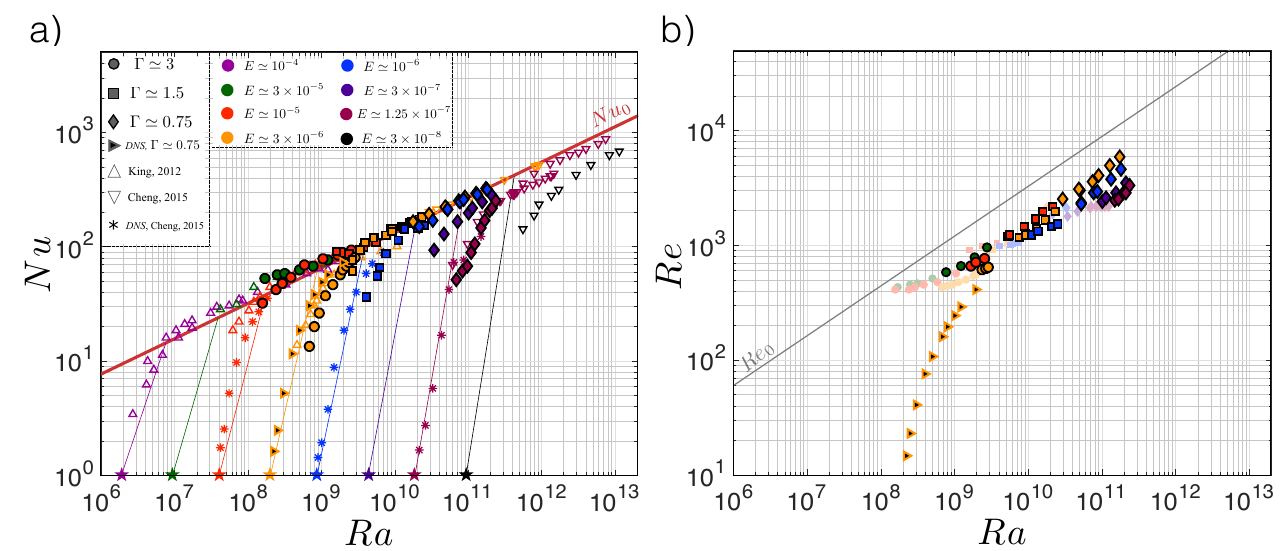
Figure 5. ( a ) Nu vs. Ra RRBC results, where circles denote laboratory data with Γ 3, squares denote (cid:39) laboratory data with Γ 1.5, and diamonds denote laboratory data with Γ 0.75. Color represents (cid:39) (cid:39) the non-dimensional rotation period, E . The right pointing orange triangles with black centers represent the fixed Γ 0.74, E 3 10 − 6 DNS of this study. Open, colored triangles represent the (cid:39) (cid:39) × data from [64] and open, colored upside-down triangles represent the data from [65]. The asterisks denote the DNS from [65]. The onset of steady convection, given by (11), is shown as solid, colored stars. The colored, thin solid lines past onset characterize the regime given by (12) and (13). The thick fuchsia line shows the RBC empirical findings from Figure 4a. ( b ) Re vs. Ra RRBC results, where the colors and symbols are the same as those in (a) but with one difference: faded symbols represent the data with measured velocities that are below the determined resolution limit of 2.5 mm/s for the LDV device used in this study while solid symbols represent the data above this resolution limit. The solid, faded black line is the best fit to the RBC momentum transfer data shown in Figure 4b, serving as an upper bound for the rotating data.